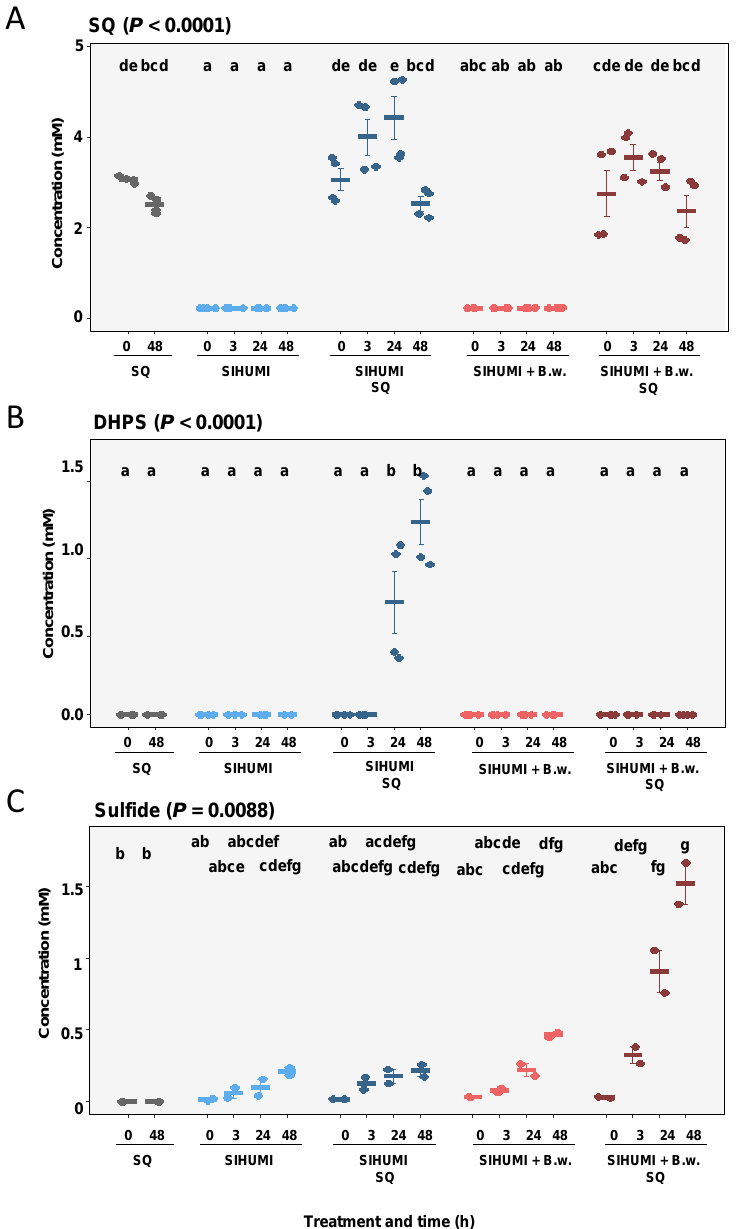
Figure 4. Mean concentrations of SQ ( A ), DHPS ( B ) and sulfide ( C ) at 0, 3, 24 and 48 h in substrate control with SQ, simplified human intestinal microbiota (SIHUMI), SIHUMI with SQ, SIHUMI and Bilophila wadsworthia , and SIHUMI and Bilophila wadsworthia with SQ. Error is SEM. P calculated according to Kruskal–Wallis tests with post hoc Dunn tests. Di ff ering letters depict significant di ff erences between